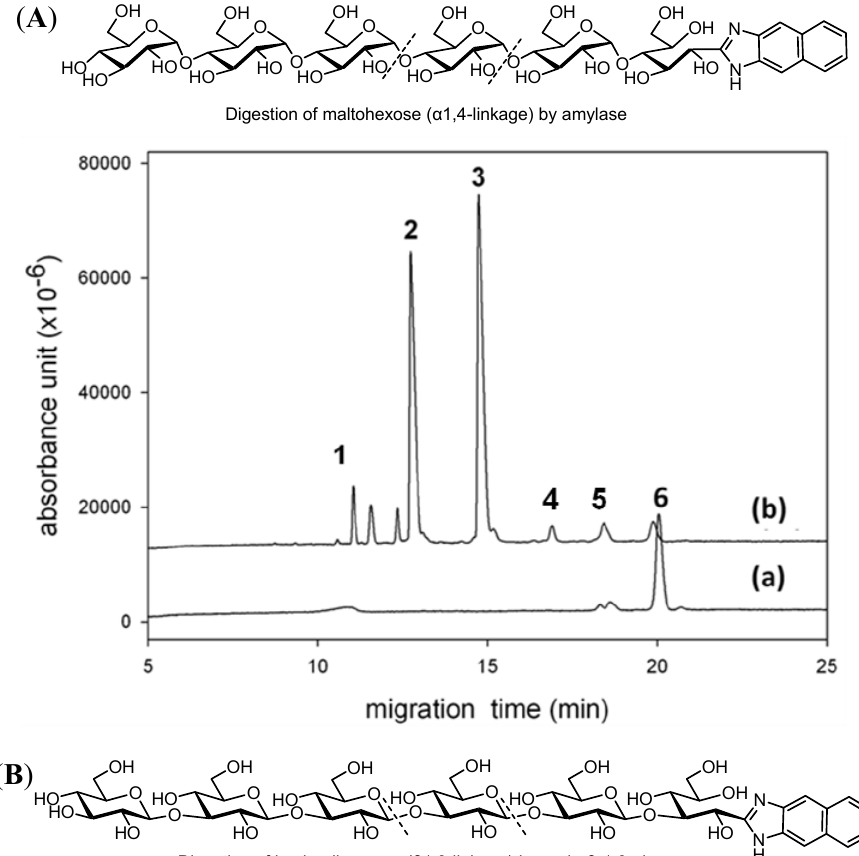
Figure 3. CE analysis of enzymatic digestion of oligosaccharides. The peaks were identified by comparison with standard saccharide–NAIMs. ( A ) Electropherograms of maltohexaose-NAIM derivative (trace a) and after digestion by α -amylase (trace b). Peaks: 1 = glucose-NAIM; 2 = maltose-NAIM; 3 = maltotriose-NAIM; 6 = maltohexaose-NAIM. The peaks at 11.6 and 12.4 min are not identified. ( B ) Electropherograms of laminarihexaose-NAIM derivative (trace c) containing minor components of pentamer and heptamer, and after digestion by endo- β -1,3-glucanase (trace d). Peaks: 2 = laminaribiose- NAIM; 3 = laminaritriose-NAIM; 4 = laminaritetraose-NAIM; 5 = laminaripentaose- NAIM; 6 = laminarihexaose-NAIM; 7 = laminariheptaose-NAIM. The peaks at 12.2 and 14.3 min are not identified. ( C ) Electropherograms of cellohexaose-NAIM derivative (trace e) and after cellulase digestion (trace f). Peaks: 1 = glucose-NAIM; 2 = cellobiose-NAIM; 6 = cellohexaose-NAIM. CE conditions: uncoated fused-silica capillary of 30 cm (effective length) × 50 μ m id; phosphate buffer (300 mM, pH 3.0); applied voltage of 15 kV (detector at cathode side); sample loaded by pressure for 5 s; detection wavelength at 254